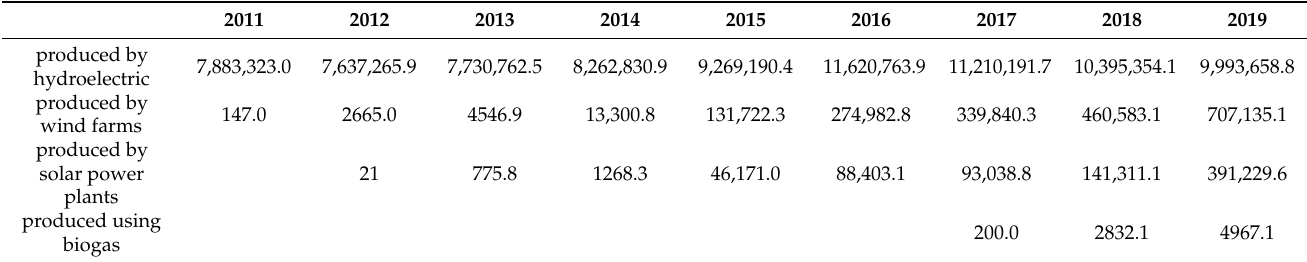
Table 1. Structure of production of renewable energy sources in Kazakhstan, thousand